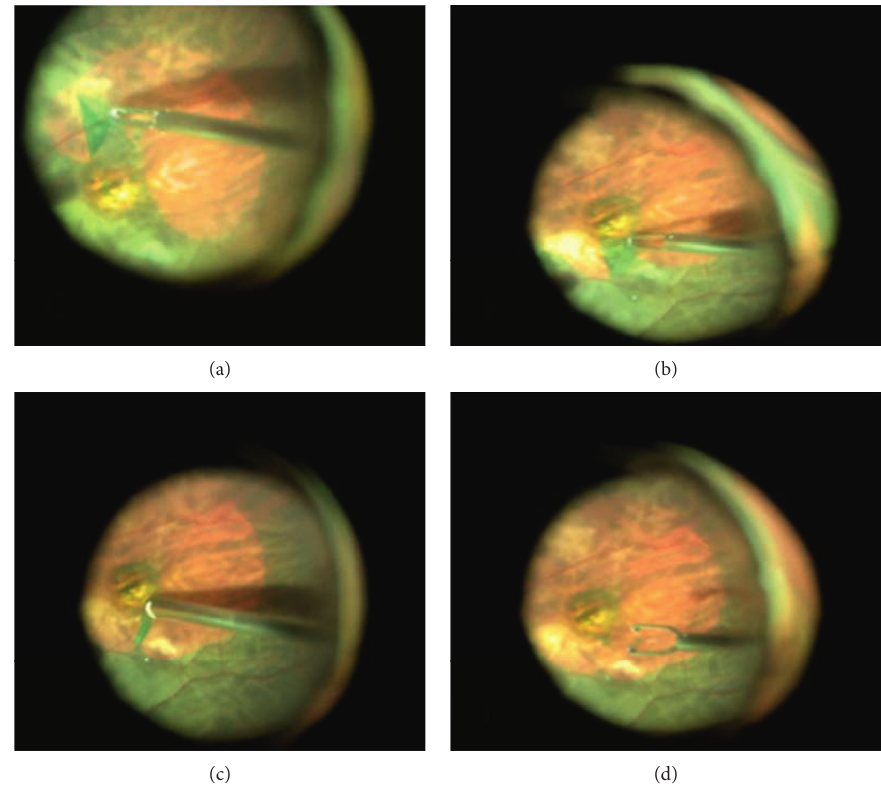
Figure 1: “Arc-shaped foldback” fovea-sparing ILM peeling procedure. (a) After ICG staining, initial ILM tear was performed away from the central fovea at the temporal side, and it was peeled from the outside to the paracentral fovea and then folded back in an arc-shaped manner, followed by removal with special attention not to peel the ILM around the central fovea; (b) ILM flap was made at the superonasal side and peeled toward the paracentral fovea; (c) the narrow strip of ILM was excised with a vitreous cutter. (d) The circular epifoveolar ILM of about 1/3 of the optic disc diameter was